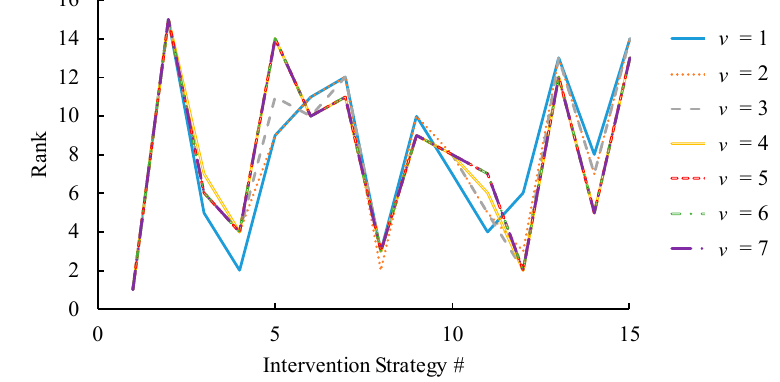
Figure 12. Ranking results with various values of v .